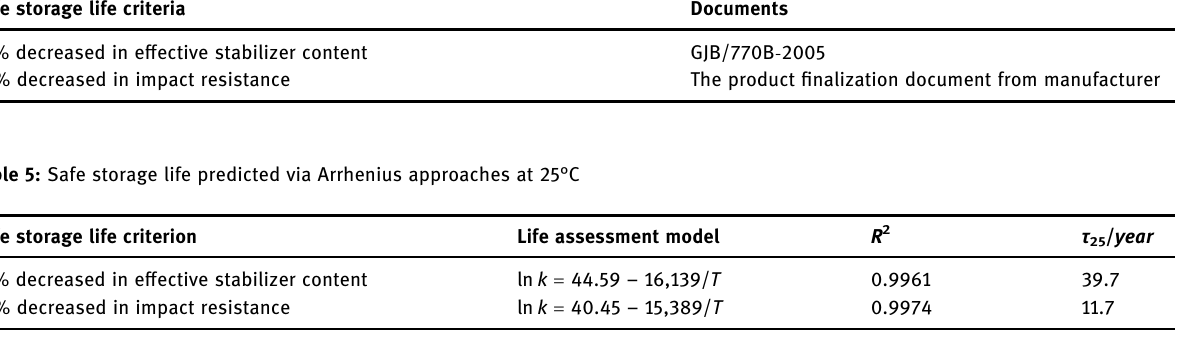
Table 4: Safe storage life criteria of GaTo propellants Safe storage life criteria